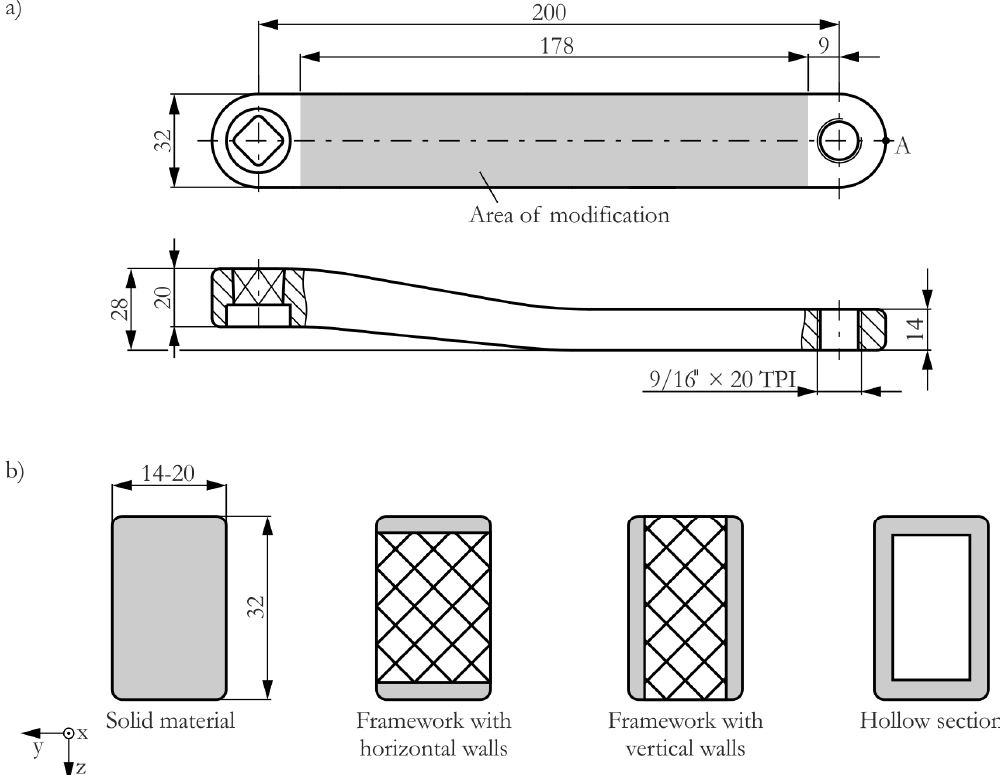
Figure 8: Dimensions of the personalised bicycle crank a) and variants of geometry for the cross section in the area of modification